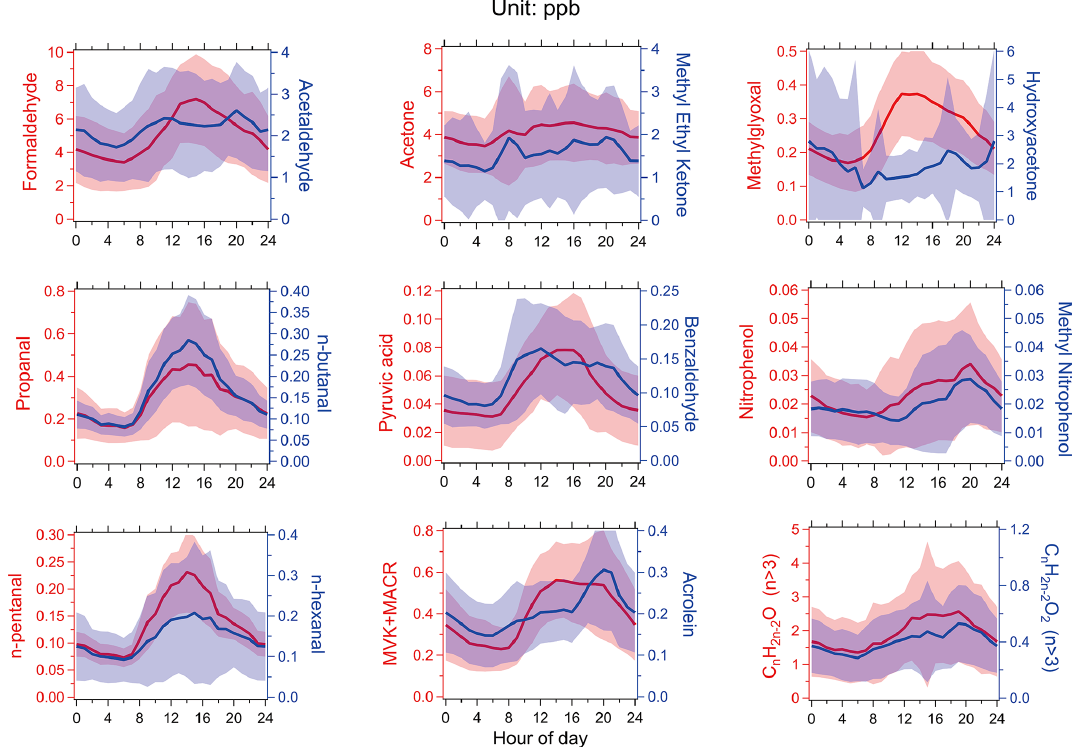
Figure 1. The average diurnal variations of the concentrations of photodegradable OVOC species during the field campaign in Guangzhou. Lines and shading represent averages and standard deviations,